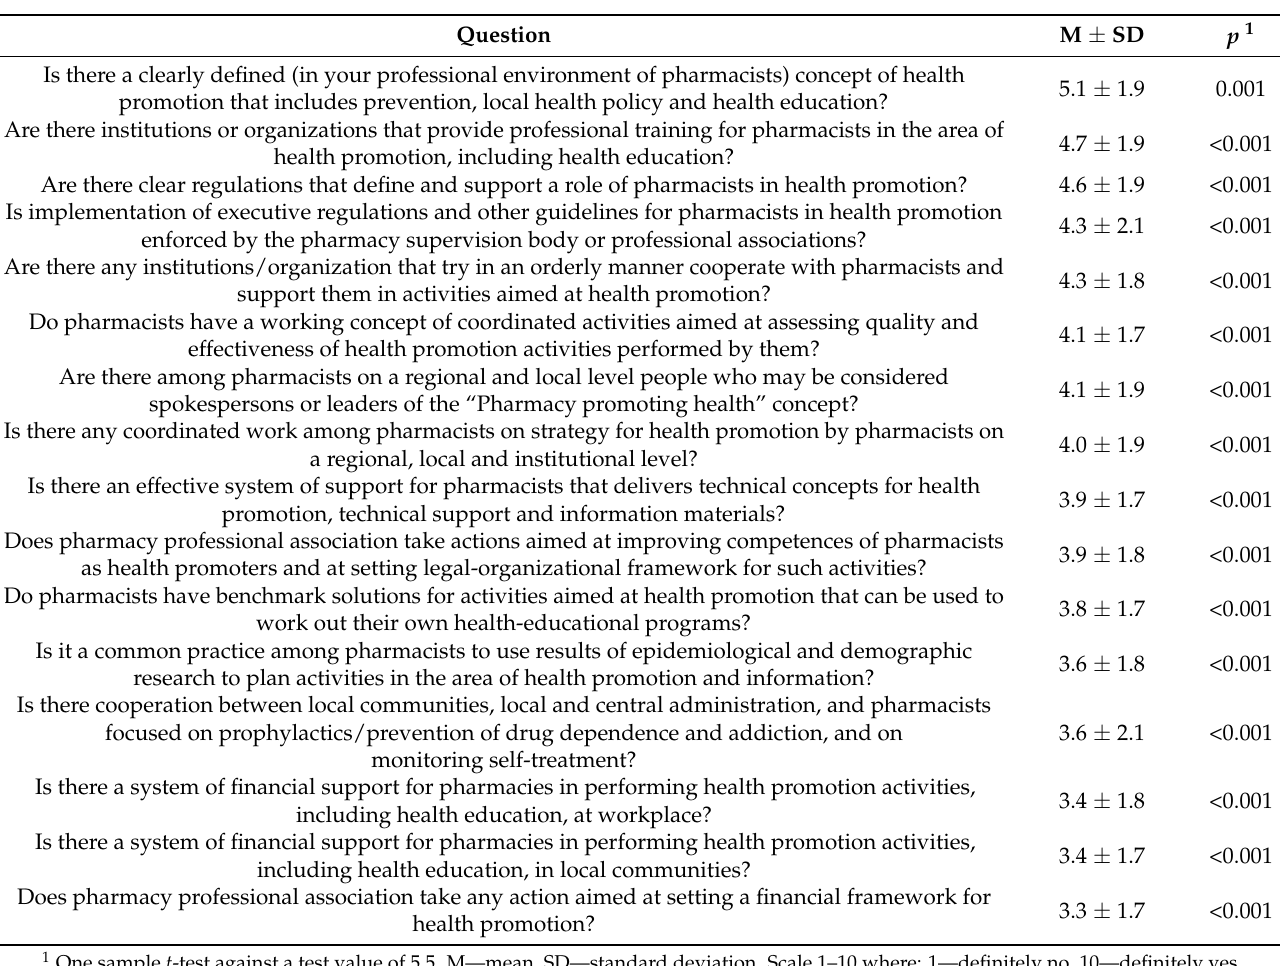
Table 2. Pharmacy students’ assessment of systemic solutions for health promotion (N = 206). Question M ± SD p 1